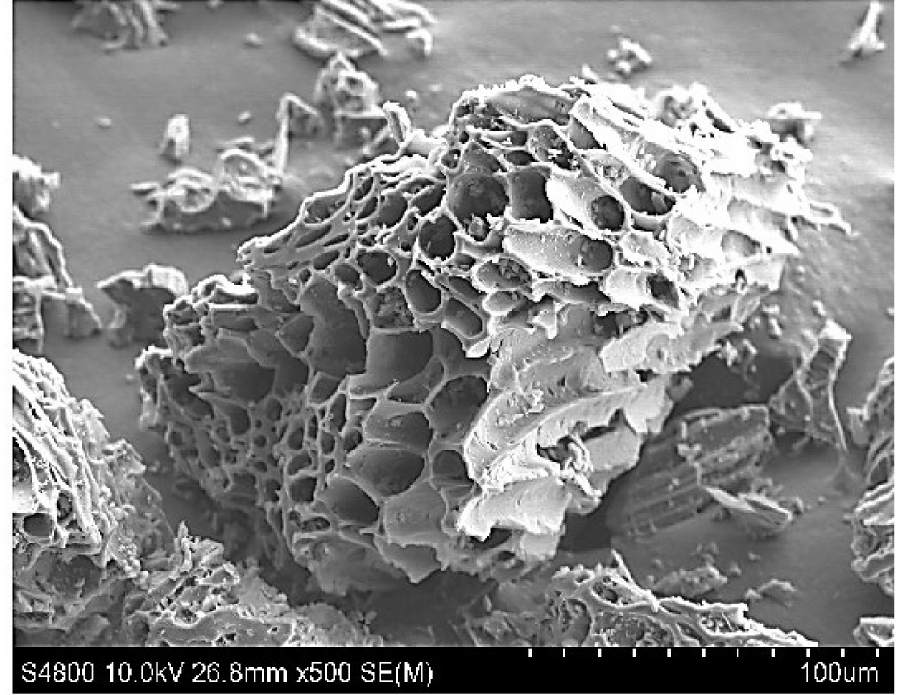
Figure 7. SEM image of highly porous characteristics of activated carbon full of cavities. Adapted with permission from Ref.